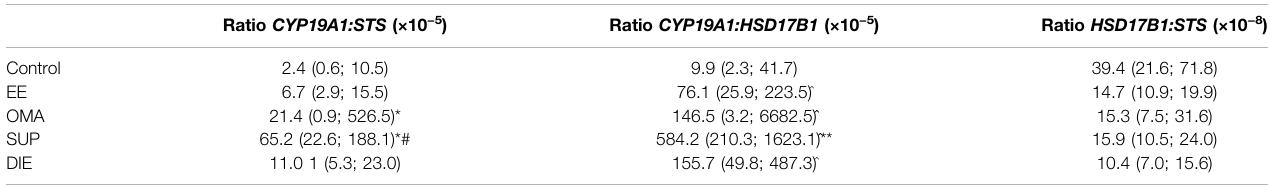
TABLE 1 | Gene expression ratio among CYP19A1 , STS , and HSD17B1 in biopsies from endometriotic lesions and from eutopic endometrium of non-endometriosis patients